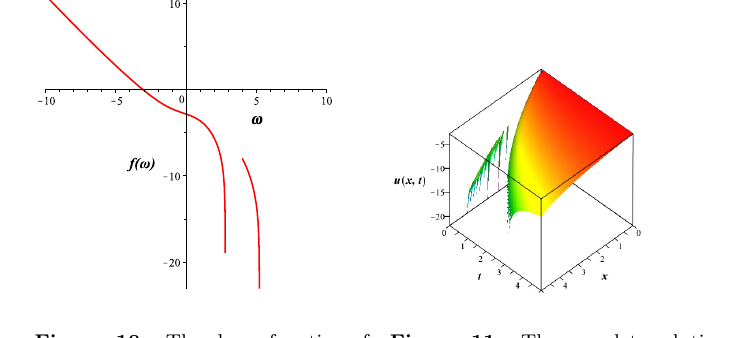
Figure 11. The complete solution u ( x,t ) for the blue noise with the parameters given